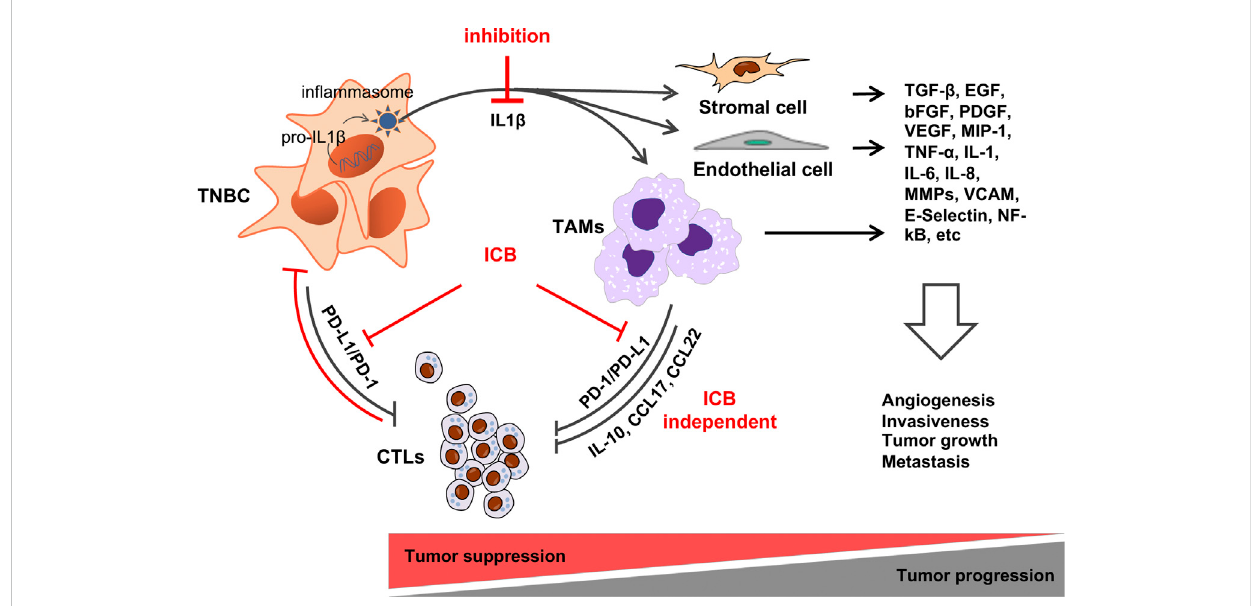
FIGURE 1 Hypothesis: IL1 β -induced TAM recruitment to TNBC promotes tumor progression by inducing immune suppression. TAMs can suppress CTLs via immune checkpoint-dependent and - independent mechanisms making ICB ineffective. By preventing TAM recruitment, and the activation of other cell types within the TME, IL1 β inhibition will prevent angiogenesis, tumor cell invasion, metastasis and convert tumors to an ICB-sensitive state. See text for